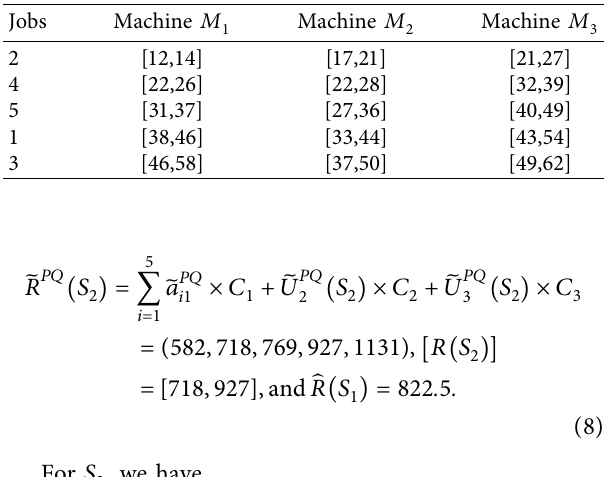
Table 10: The in-out flow for S